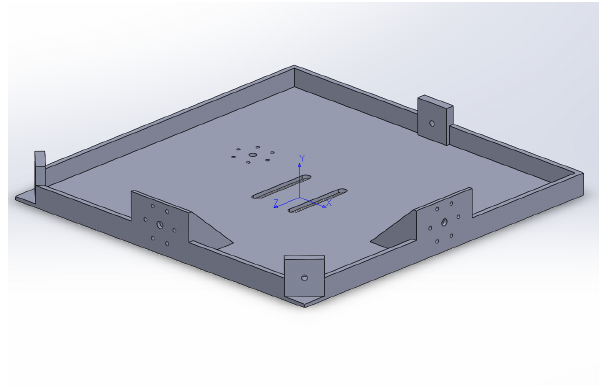
Figure 4. SOLIDWORKS CAD base model, axonometric view.